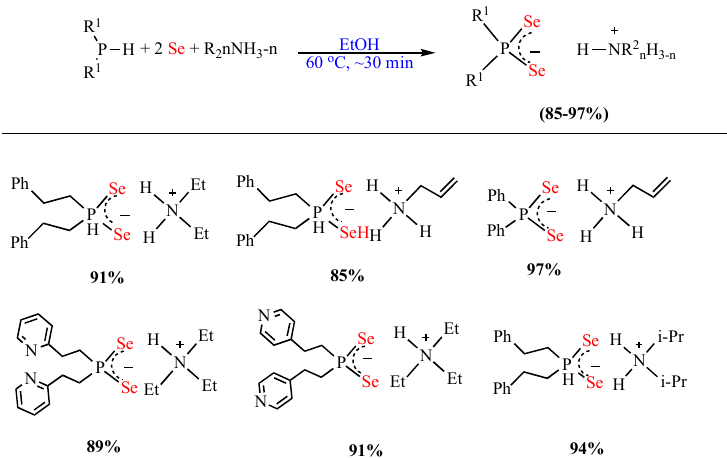
Scheme 13. Synthesis of alkylammonium diselenophosphinates.